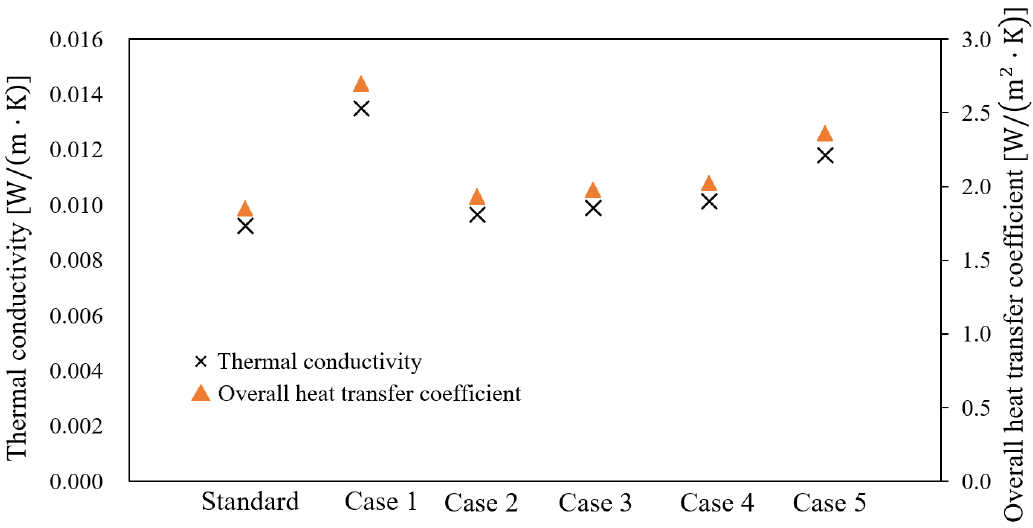
Figure 14. Comparison of the calculated results for the case studies.